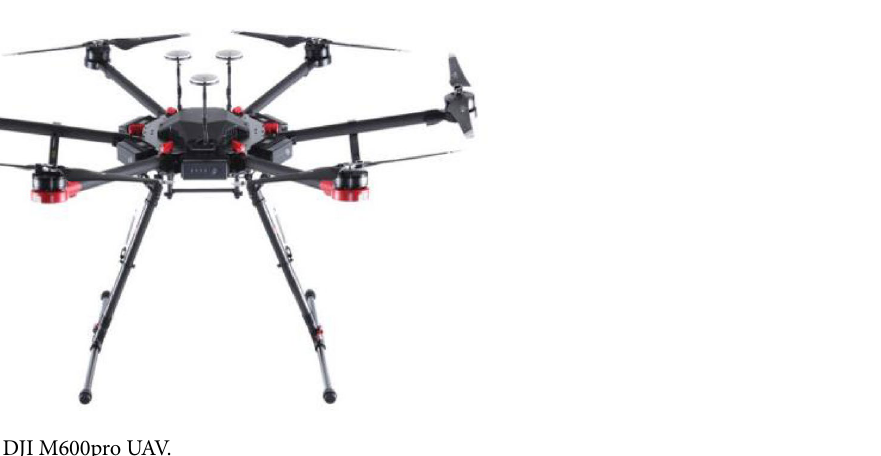
Figure 2. DJI M600pro